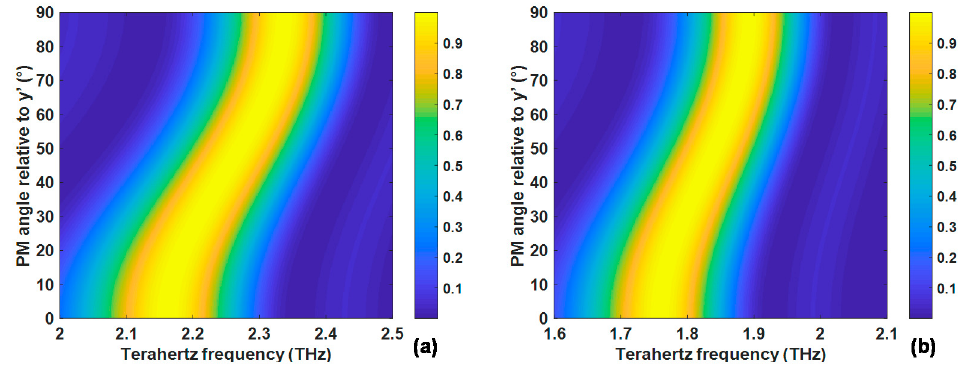
Figure 5. Relative PM efficiency of collinear angle tuning in the y’oz’ plane of ZnTe and CdTe with a − 9 kV voltage along the [001] direction: ( a ) ZnTe and ( b ) CdTe.